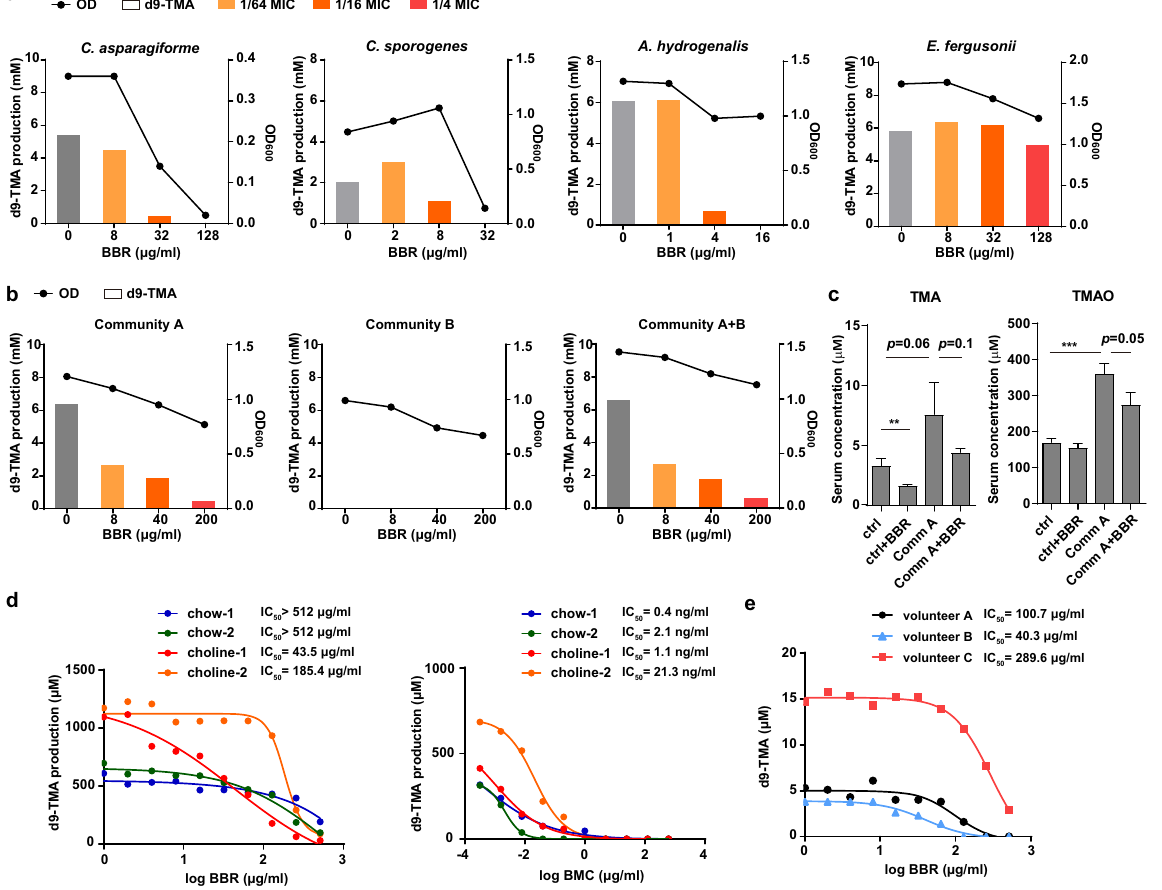
Fig. 6 BBR inhibits anaerobic d9-TMA formation in vitro or ex vivo in a dose-dependent manner. a BBR inhibits d9-TMA formation from d9-choline in TMA-producing gut bacteria, including C. aparagiforme , C. sporogenes , A. hydrogenalis, and E. fergusonii under anaerobic condition. The production of d9-TMA was measured at 6 h by HPLC-MS/MS. The fi nal concentrations of BBR were 1/64, 1/16, 1/4 of the MIC of each strain. b Effects of BBR on bacteria mixture under anaerobic condition. Four strains of TMA producing bacteria (Community A), four of non-TMA producing bacteria (Community B), and all eight (Community A + B) were cocultured with d9-choline for 3 h anaerobically. The d9- TMA productions were measured with HPLC-MS/MS. c BBR inhibits serum TMA and TMAO levels increased by colonization of TMA-producing bacteria. Choline supplemented chow-fed C57BL/6J mice were colonized with or without TMA-producing bacteria (Community A) and treated with or without BBR for 8 d. Values were presented as means ± SEM (** p < 0.01; *** p < 0.001; n = 5). d Effects of BBR on TMA-producing ability of mice gut microbiota under anaerobic condition ex vivo. The intestinal microbiota of the feces from chow or choline diet-fed C57BL/6J mice ( n = 5 for each cage, the feces of the same cage were pooled) were used for the ex vivo assay. The production of d9-TMA was measured at 14 h. Dose-response curves were fi t using nonlinear regression to determine IC 50 values. BMC, bromomethylcholine. e BBR inhibits d9-TMA formation from d9-choline by human fecal suspension under anaerobic condition ex vivo. The fecal microbiota of three volunteer (A, B, C) were used for the ex vivo assay. The production of d9-TMA was measured at 6 h. Dose-response curves were fi t using nonlinear regression to determine IC 50